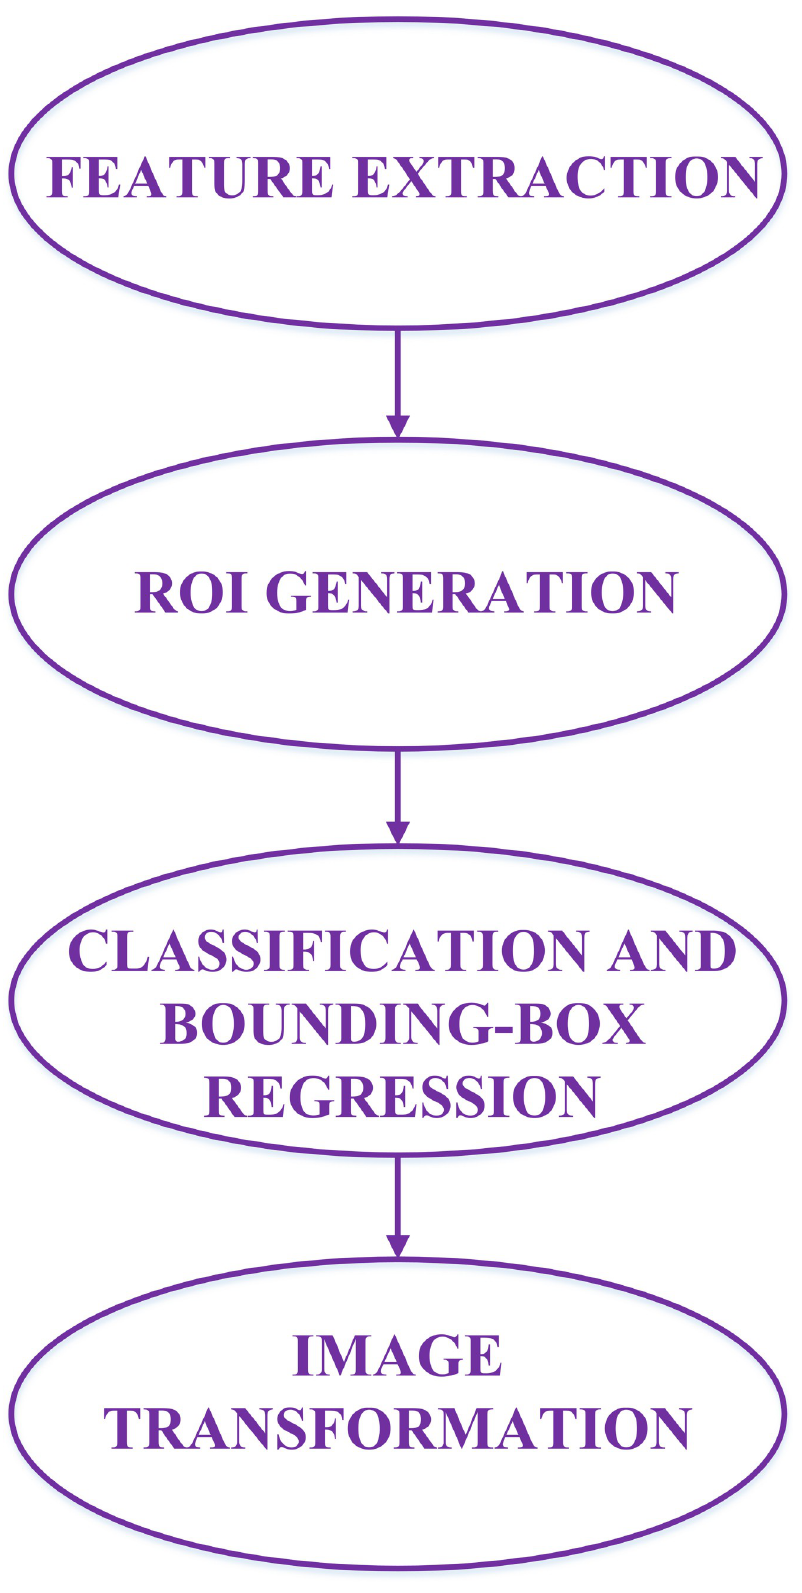
Fig 2. The flowchart about our target detection process. https://doi.org/10.1371/journal.pone.0266734.g002 PLOS ONE | https://doi.org/10.1371/journal.pone.0266734 August 1,